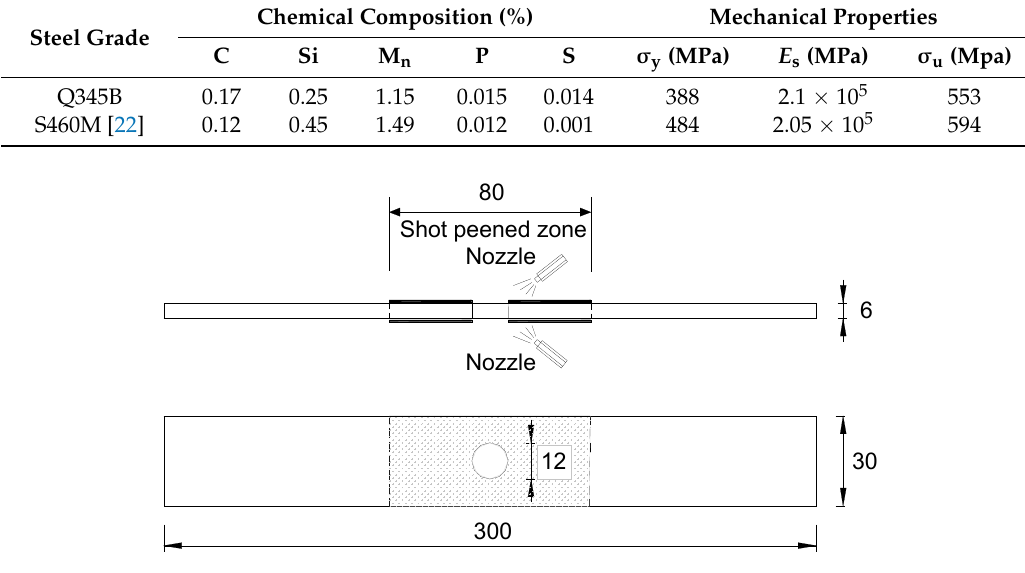
Figure 1. Dimension and design of test specimen (unit: mm). Table 2. Shot peening conditions.